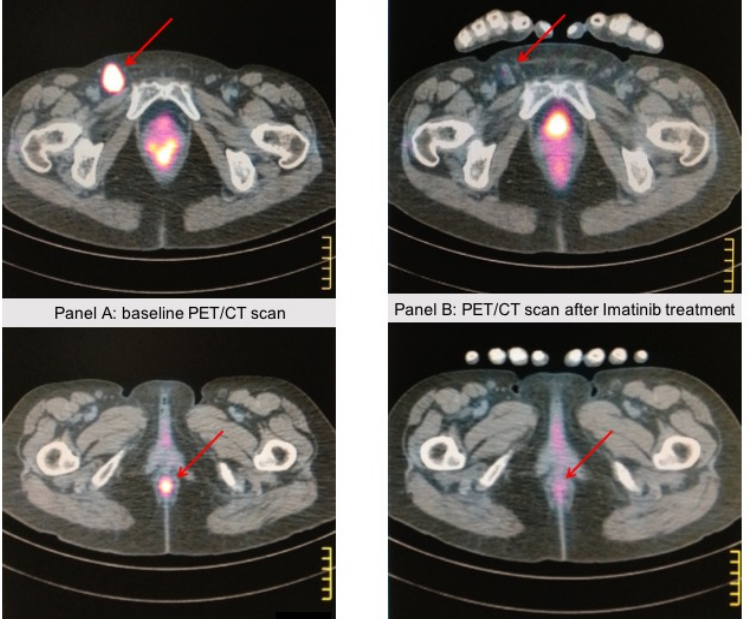
Figure 2. A 67-year-old patient came to our attention because of rectorrhagia; a PET/CT scan showed lung and abdominal lymph node metastases. A biopsy of the anal mass showed atypical epithelioid cells with pleomorphic features. Immunohistochemistry showed strong positivity for HMB45 and Melan A, whereas cytokeratins and S-100 expression were negative, consistent with the diagnosis of anal mucosal melanoma. c-KIT staining was positive in >75% of tumor cells, and DNA sequence analysis revealed a KIT -activating mutation (L576P) in exon 11. The patient received Imatinib 400 mg/die. Panel ( A ) shows the anal baseline lesion with a pathologic left inguinal lymph node. Panel ( B ) shows the PET/CT scan after 4 months of Imatinib treatment, showing a near-complete response in the anal lesion and the inguinal lymph node. The response lasted 3 years, then the patient progressed and died. These images come from the radiology archive of a patient with mucosal melanomas, as indicated in the “Materials and methods”